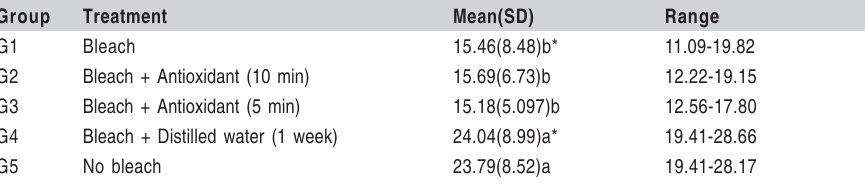
Table 2: Mean micro-shear bond strength values, standard deviation and range of each group.